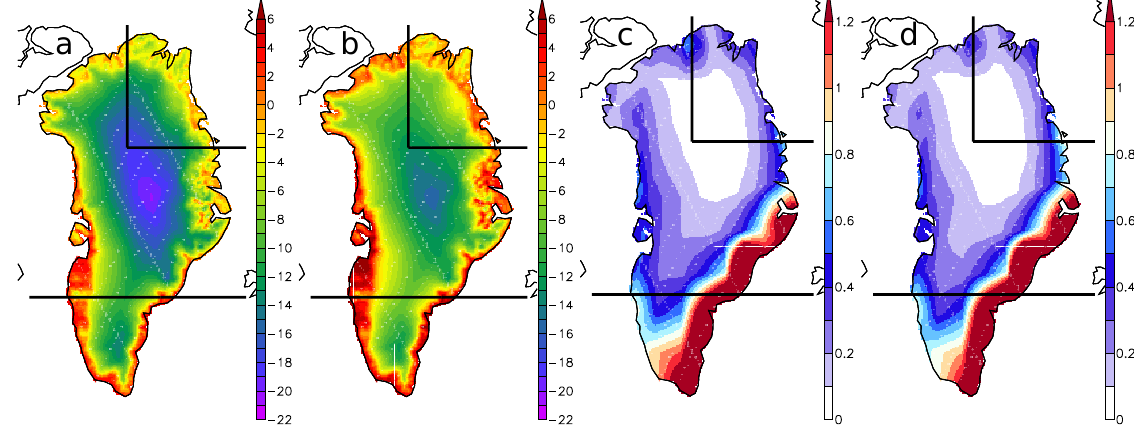
Fig. 2. Seasonal averages of forcing fields from IPSL CM4, interpolated onto the ice sheet model grid. Temperature data has been corrected with a fixed lapse rate of − 6.5 ◦ Ckm − 1 to adjust for height differences between ice sheet and climate model. (a) Summer (JJA) surface temperature for preindustrial climate (0ka, in ◦ C), (b) JJA surface temperature for 126ka (in ◦ C), (c) Winter (DJF) precipitation for 0ka (in myr − 1 ), (d) DJF precipitation for 126ka (in myr − 1 ).